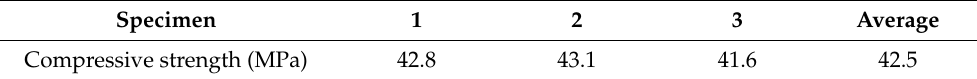
Table 2. Axial compressive strength of